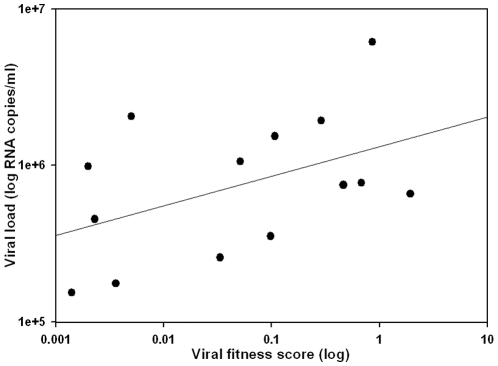
Viral fitness did not correlate with VL following analysis of isolates obtained from acute HIV-1 infection subjects.Coincident plasma VL measurements (log10 RNA copies/ml) were plotted against relative viral fitness scores (log10) for 16 isolates, obtained from plasma, from PULSE subjects. The Pearson correlation was rho = 0.496, p = 0.051.